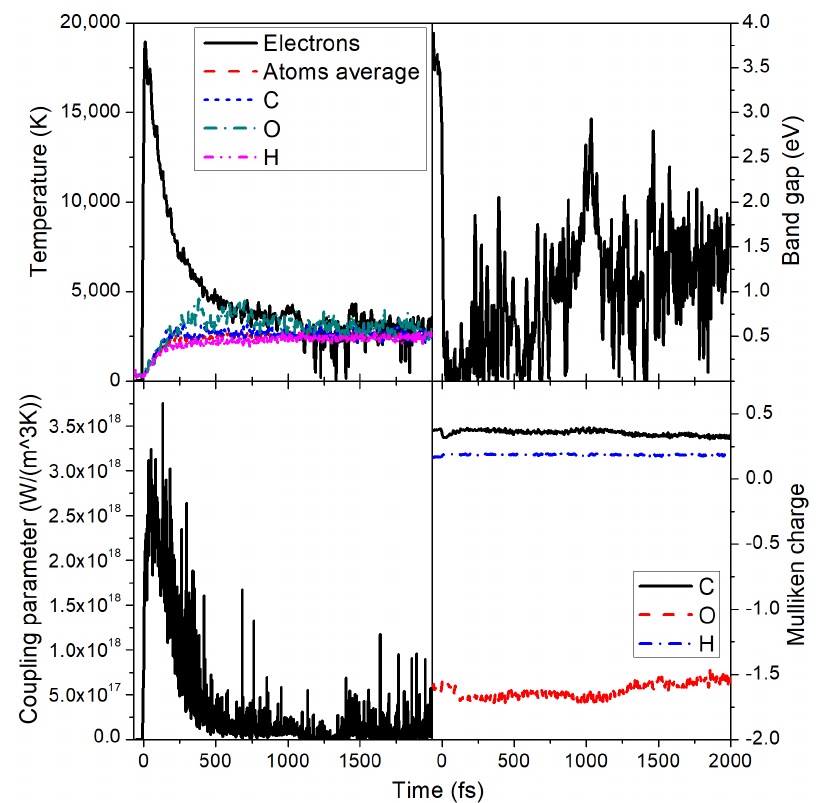
Figure 7. Several quantities in PMMA irradiated with 0.5 eV/atom deposited dose. ( Top left panel ) Electronic and atomic temperatures, together with partial temperatures of carbon, oxygen, and hydrogen atomic subsystems. ( Top right panel ) Band gap of PMMA. ( Bottom left panel ) Electron–ion (electron–phonon) coupling parameter evolution during and after irradiation. ( Bottom right panel ) Mulliken charges on carbon, oxygen, and hydrogen ions.